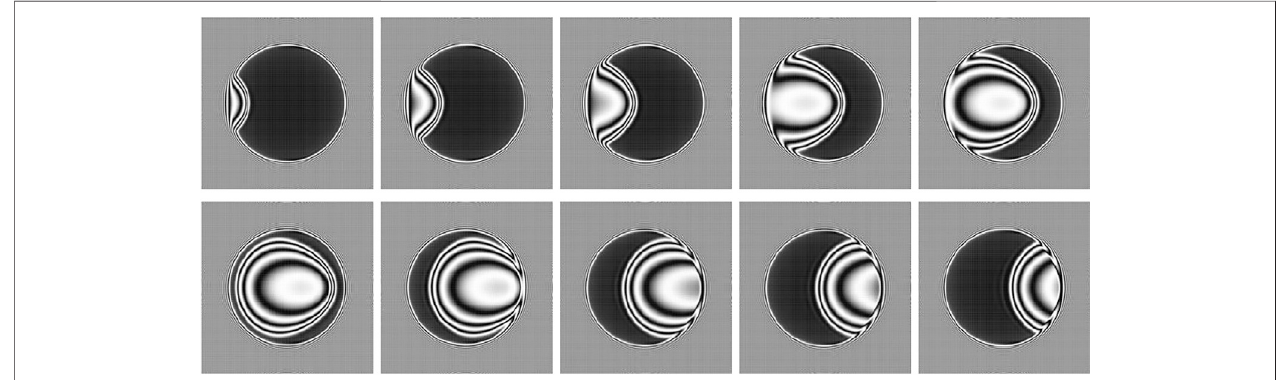
FIGURE1| Pseudo-interferogramsofthecalculated(dimensionless) fi lmthickness inacircularEHLcontactat differenttimesduring ingestionofadroplet (toprow from left to right, followed by bottom row from left to right) (van der Kruk et al., 2019).